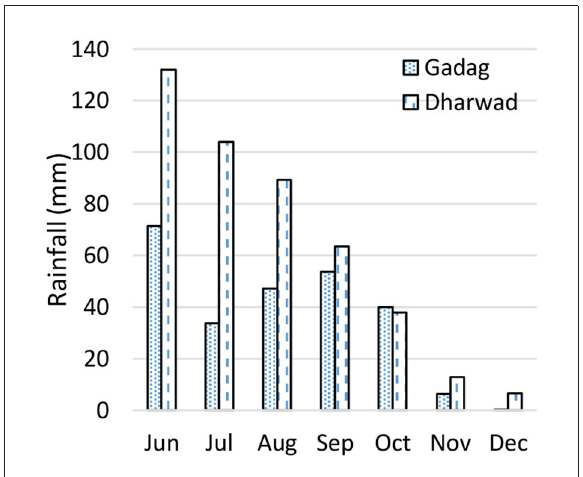
FIGURE3 Rainfall distribution in 2018. Source: KSNDMC, Government of Karnataka,